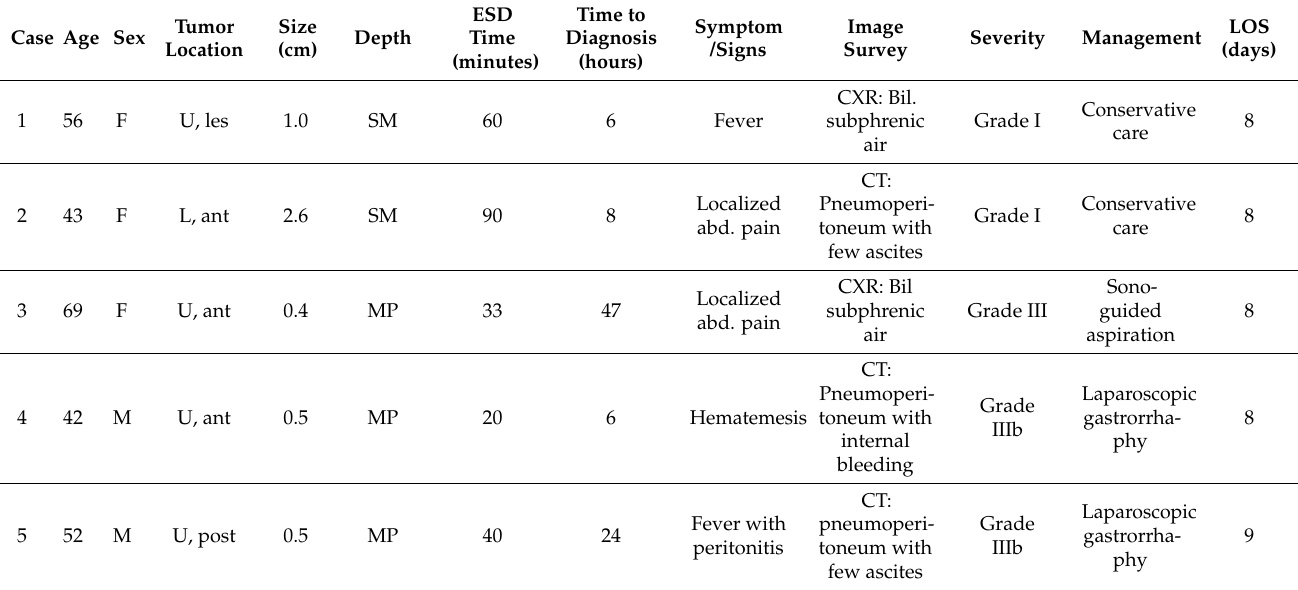
Table 2. Clinical data of five cases with delayed perforation after ESD for gastric subepithelial tumors. Case Age